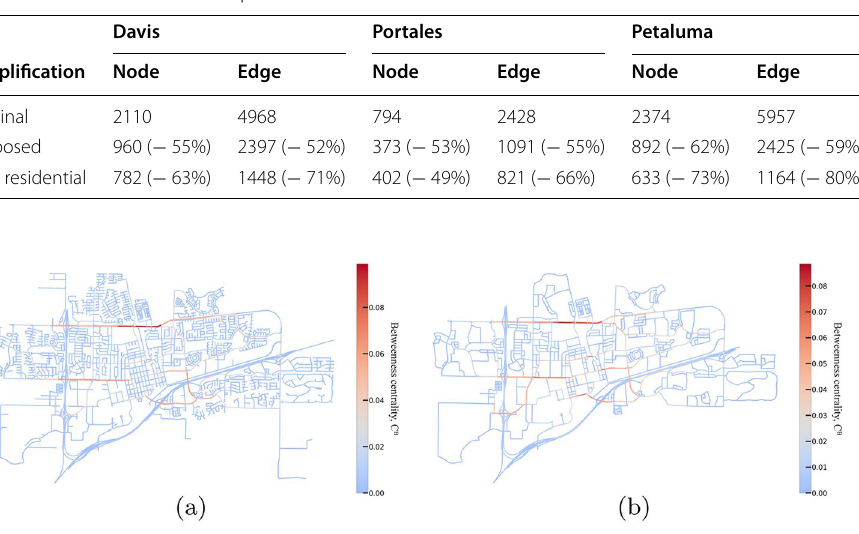
Table 2 Statistic results of simplification